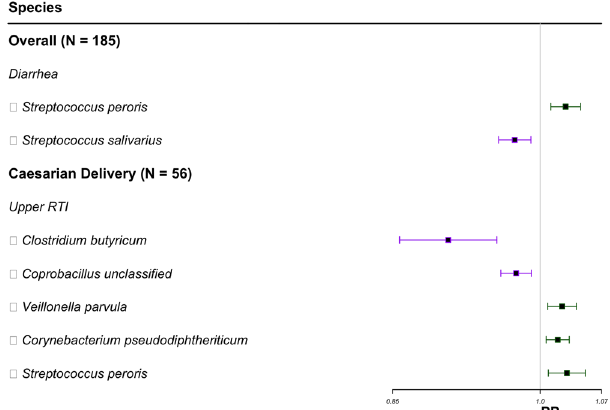
Fig. 3 Forest plot of metagenomics species associated with the number of infections and symptoms of infections in the fi rst year of life. Species selected by FDR correction presented in the forest plot. Species for vaginal deliveries did not meet the FDR threshold of 0.1. Squares represent RR, and horizontal lines represent 95% con fi dence intervals. Green represents a positive association, and purple represents a negative association. Relative risk estimates represent an increased risk of having an additional upper respiratory infection or an increased risk of experiencing diarrhea with each doubling of the relative abundance. N sample size, RTI respiratory tract infection, RR relative